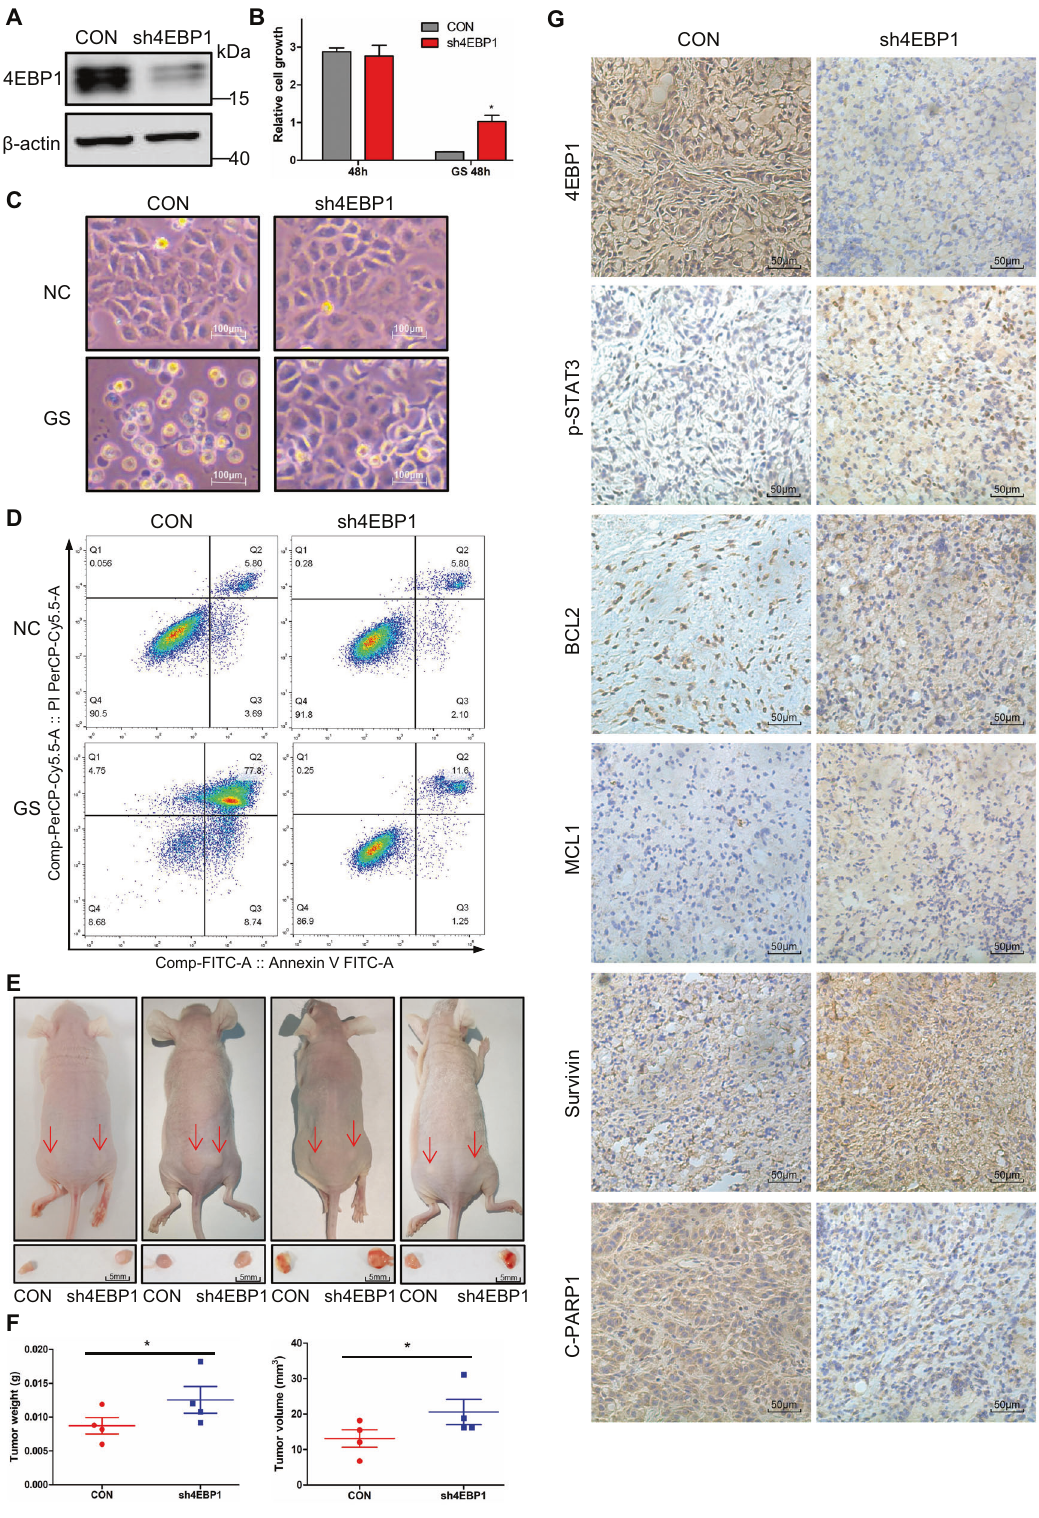
Statistical analysis Data are shown as means ± SD. paired t -tests and One-way ANOVA were used for statistical comparisons. P < 0.05 was considered to be statistically signi fi